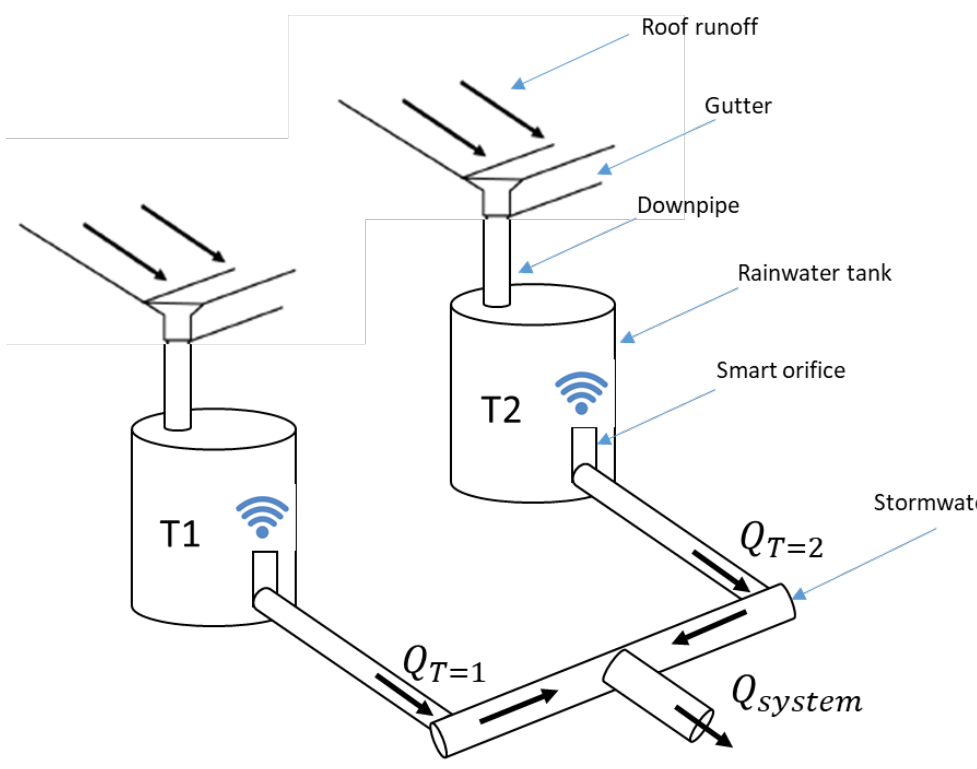
Figure 1. Schematic of an example two-tank system operated using the real-time, smart systems approach.